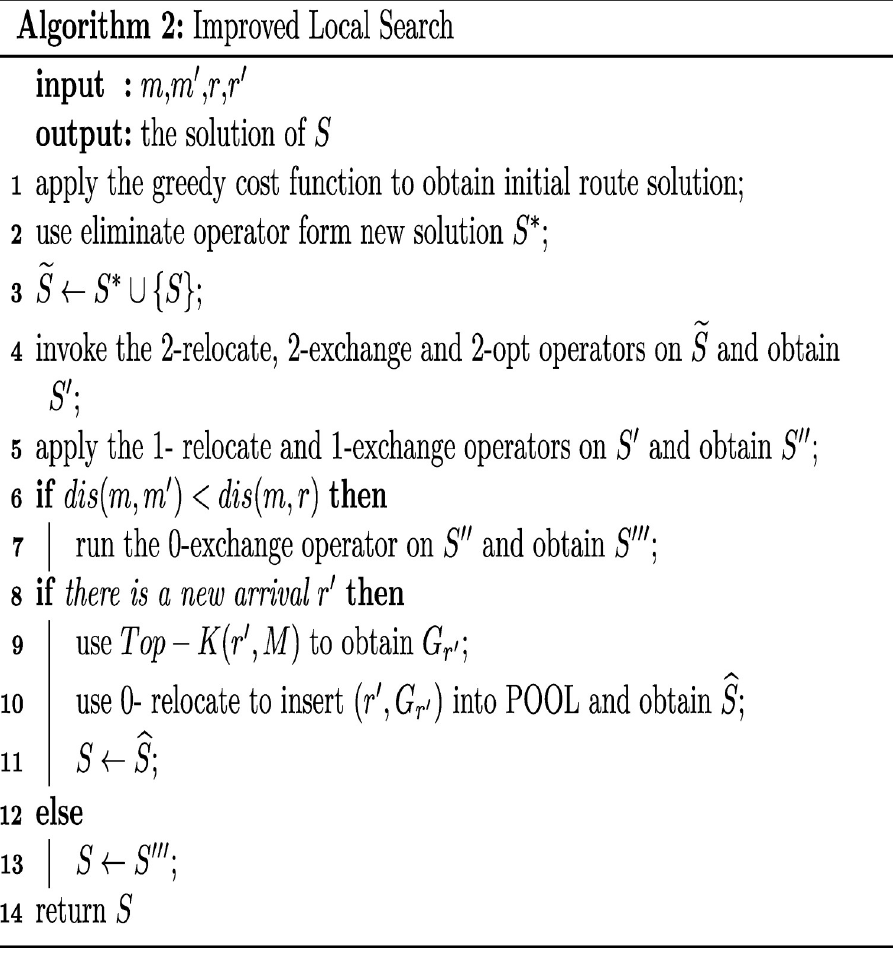
Fig 6. Improved local search. Pseudocode is used to show the running process of Algorithm